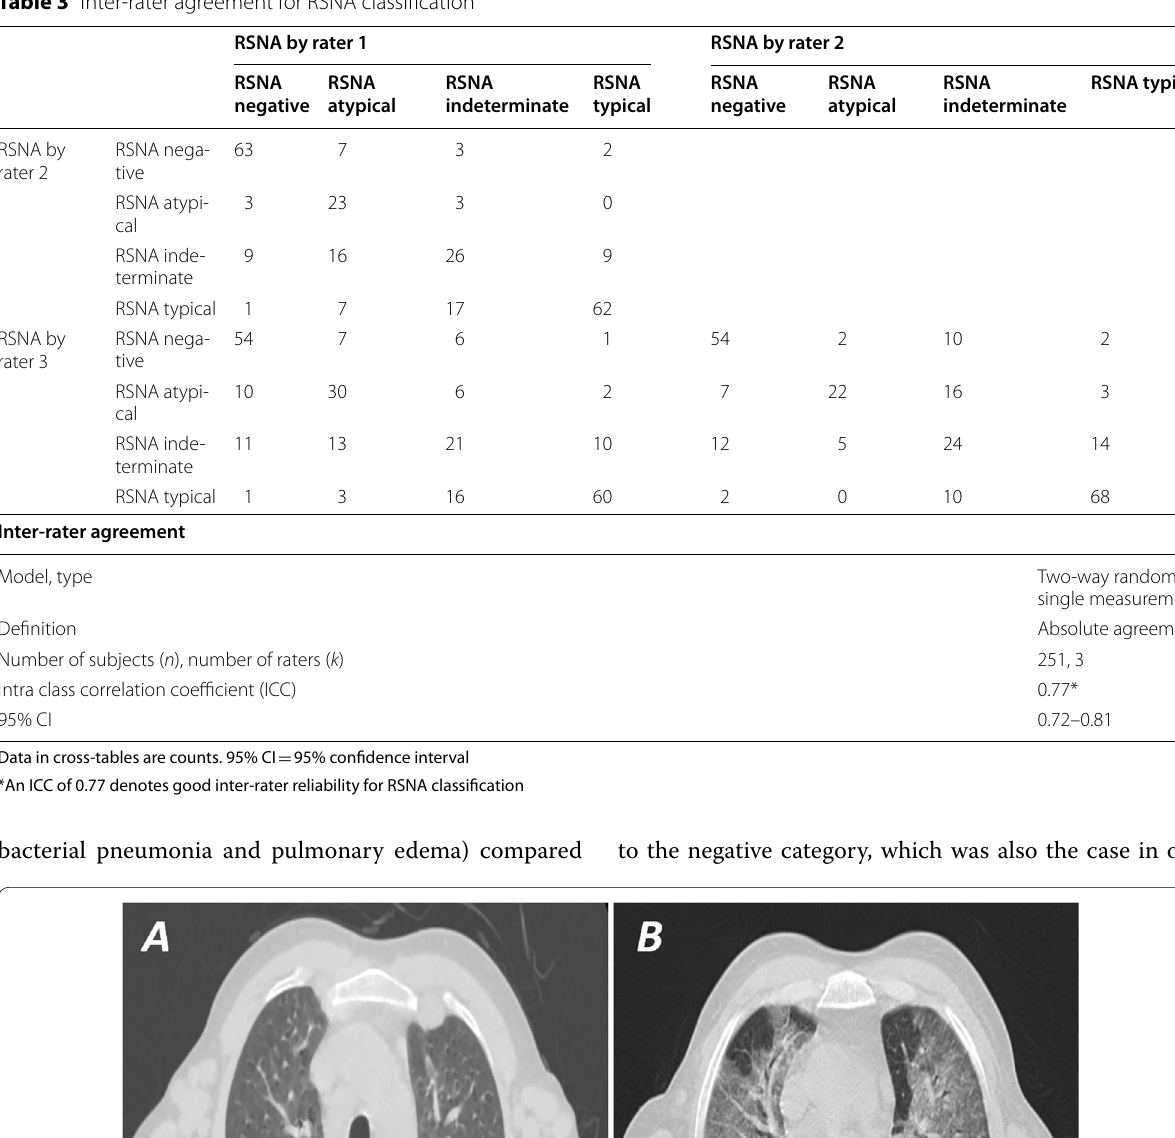
Table 3 Inter‑rater agreement for RSNA classification